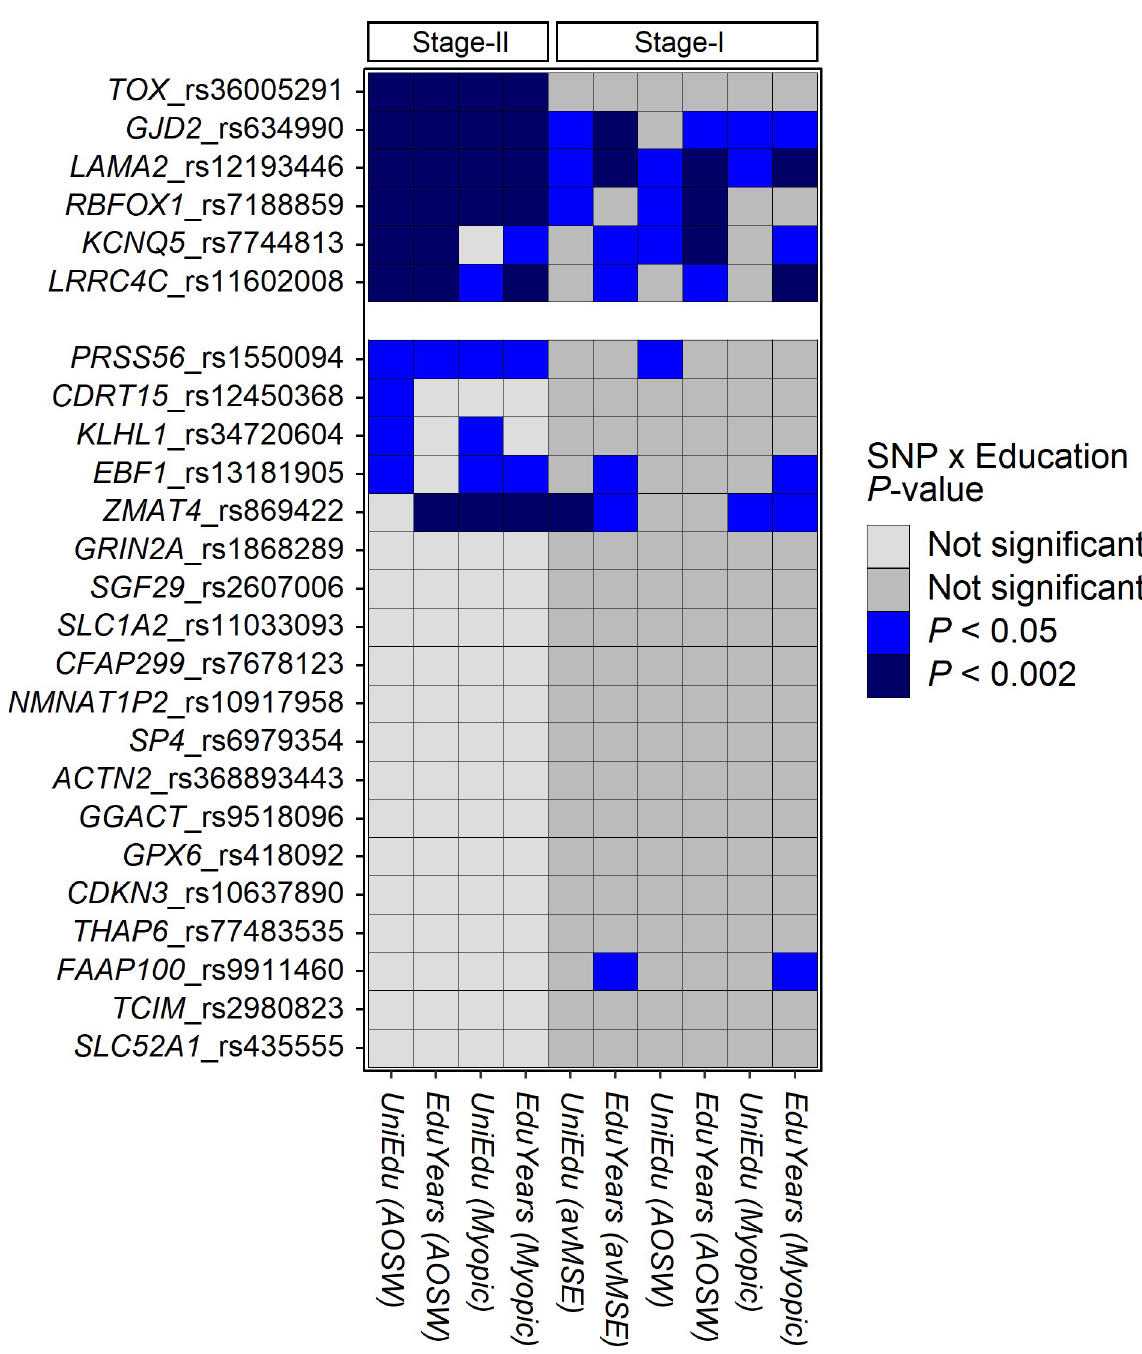
Fig 3. Summary of the evidence for SNP genotype-by-education interactions contributing to myopia development. Each tile indicates the statistical evidence (p-value) for a test of GxE interaction. Genetic variants are listed by row on the y-axis. Tests for different phenotypes ( avMSE , AOSW or Myopic ) and different indices of education ( UniEdu or EduYears ) are listed by column on the x-axis. Note that all GxE tests in the Stage-II sample will be correlated, all GxE tests in the Stage-I sample will be correlated, but that the tests in the Stage-II sample are independent of those in the Stage-I